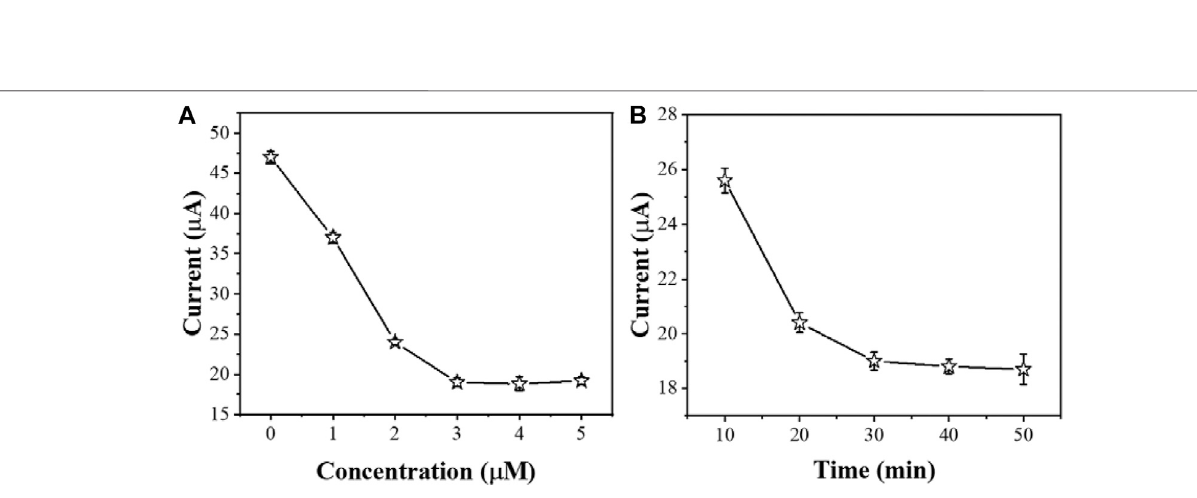
FIGURE 6 | The effect of (A) amount of AcTnI and (B) incubation time for sensing performance ( n ≥ 3).